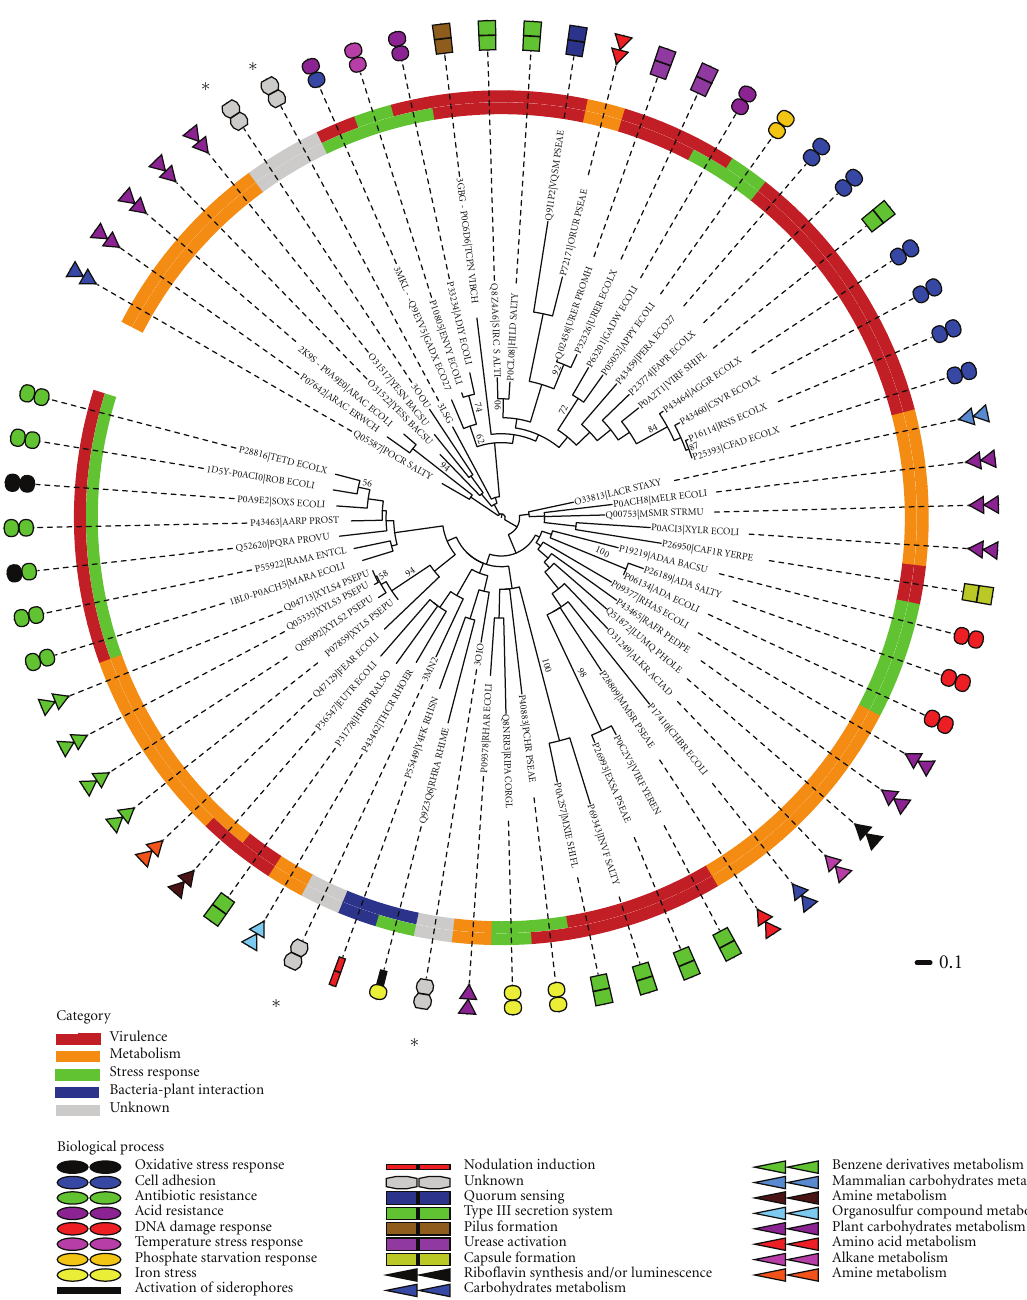
Figure 3: Dendrogram of AraC/XylS family members annotated with functional categories. A dendrogram of 62 AraC/XylS family members and four proteins found by structural similarity search and whose biological role is unknown or poorly characterized is presented (marked with an asterisk). The tree was constructed using the maximum likelihood optimization criteria and a bootstrap test was conducted with 100 replicates. Bootstrap values greater than 50 are shown as number in the corresponding nodes of the tree. Leaves contain the UniProt or PDB accession code and the protein name. Two classification levels are included in this dendrogram. The inner color strip represents a primary classification (functional category) that contains four general classes as in Figure 2. The outer circle contains several colored shapes that represent a secondary and more specific classification scheme, which provides more detail to the biological process associated with each protein. One or two functional categories were